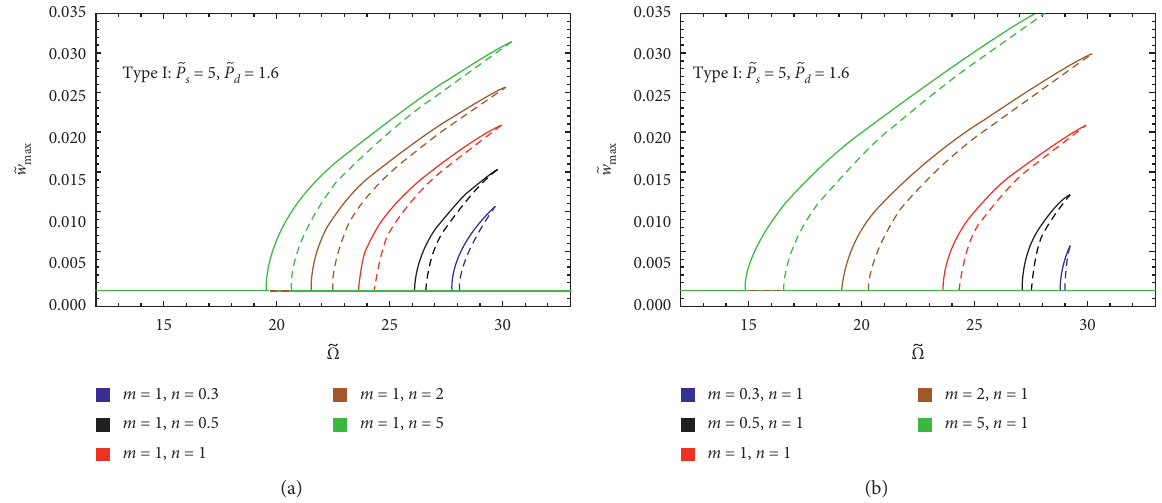
Figure 8: Frequency-response curves of the couple motions of BDFG beam with m � n � 1, L / h � 20, 􏽥 c (a, b) Maximum and minimum amplitudes of transverse motion 􏽥 w . (c) Maximum amplitudes of longitudinal motion 􏽥 u . (d) Maximum amplitudes of rotational motion ψ .